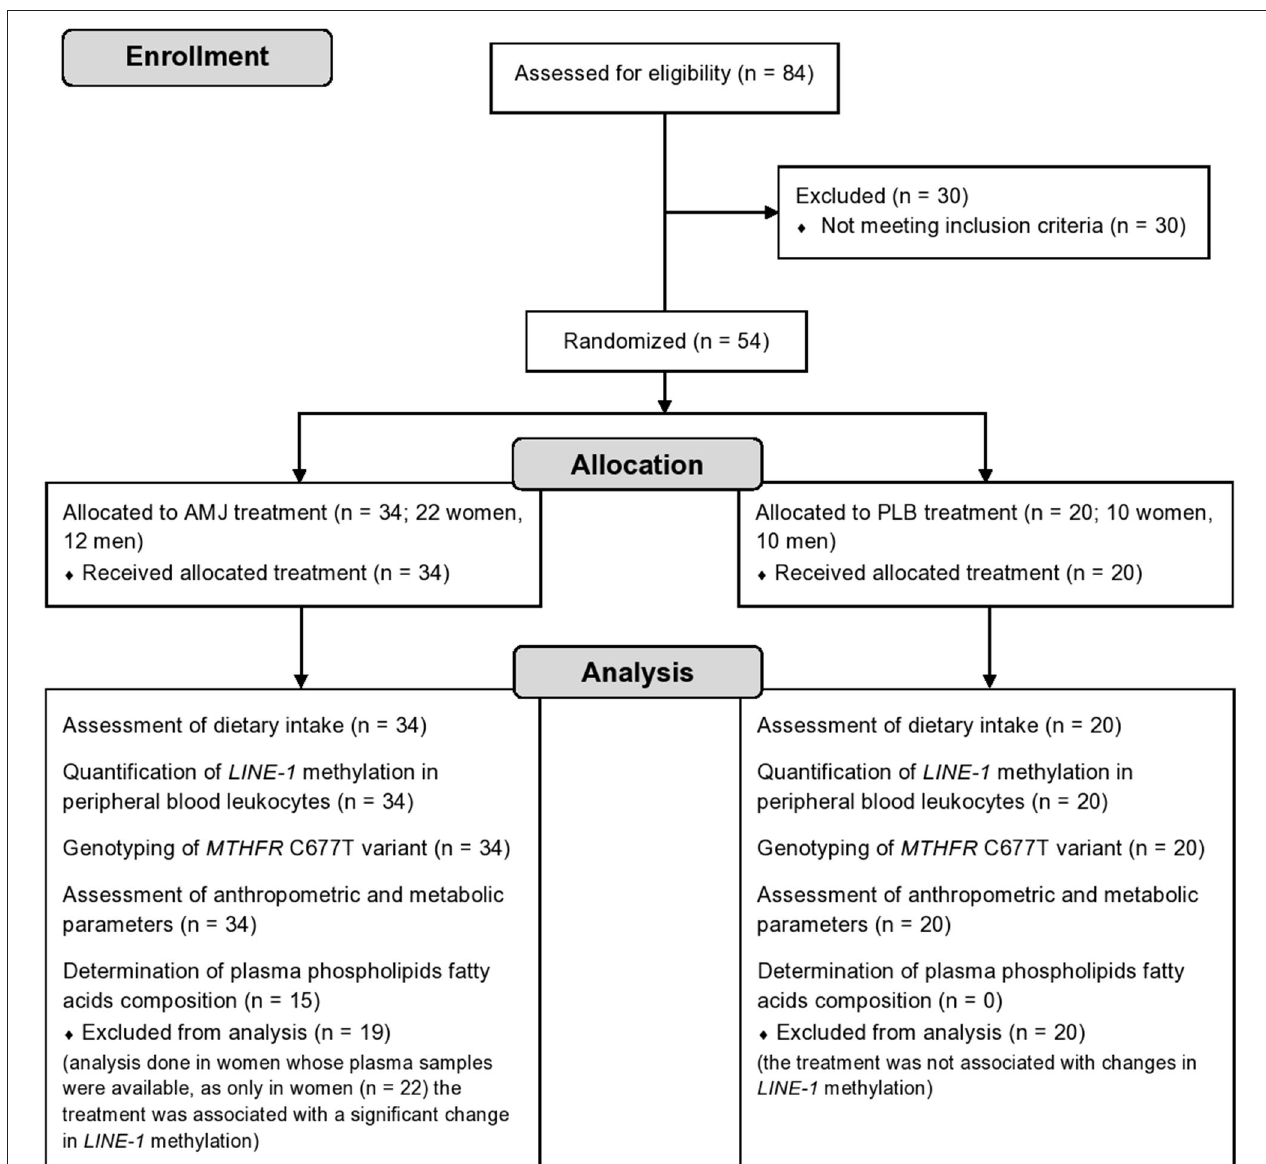
FIGURE 1 | Study flow diagram. N , number of subjects; AMJ, polyphenol-rich Aronia melanocarpa juice treatment; PLB, polyphenol-free beverage; placebo,